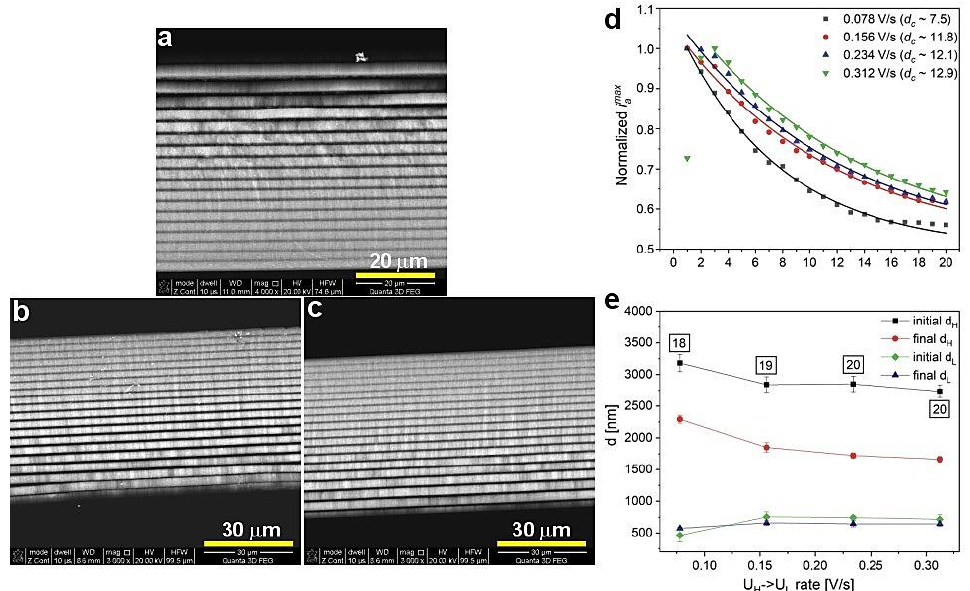
Figure 4. BSE images of the PAA synthesized at 29 °C with different U H - > U L rate: 0.156 ( a ), 0.234 ( b ), and 0.312 V/s ( c ), normalized i amax as a function of number of cycles ( d ), and initial and final d H and d L layer thickness as a function of U H - > U L rate ( e ); in black squares—the number of d H + d L pairs.